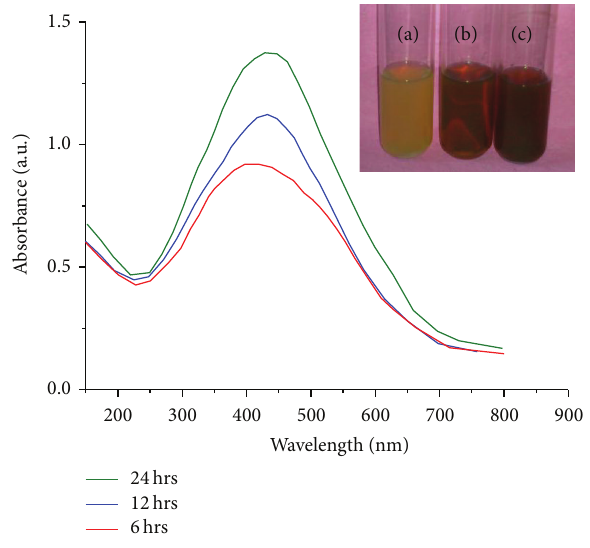
Figure 1: UV-Vis spectrum of AgNPs synthesized using fruit extract of A. marmelos : (a) control; (b) after 12h; (c) after 24 h.